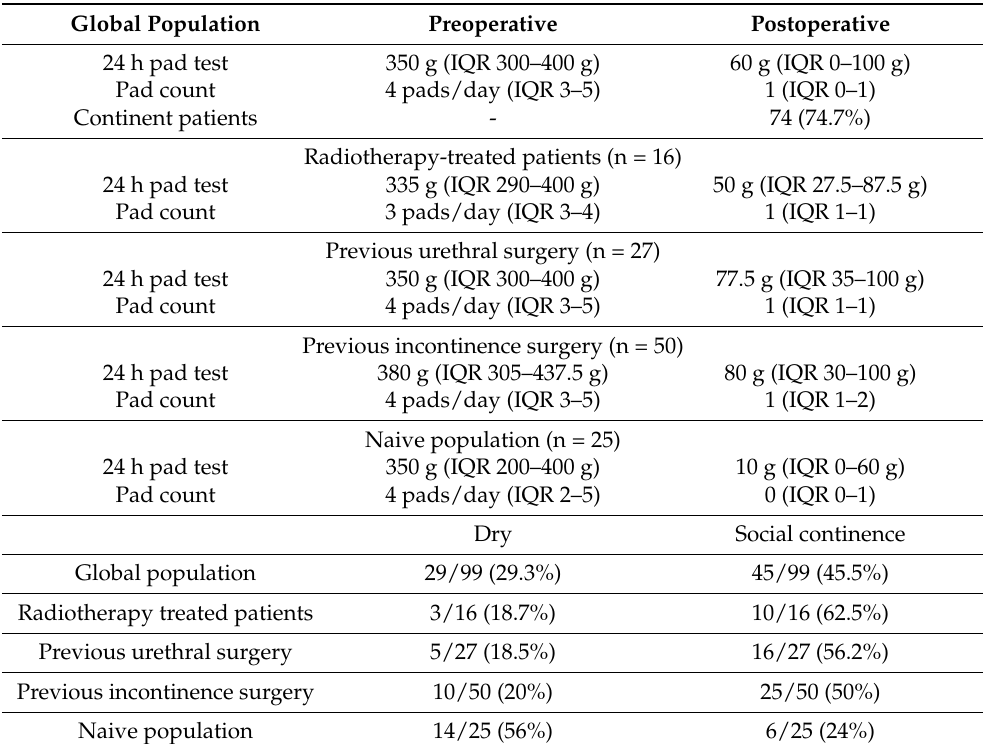
Table 3. Continence results.